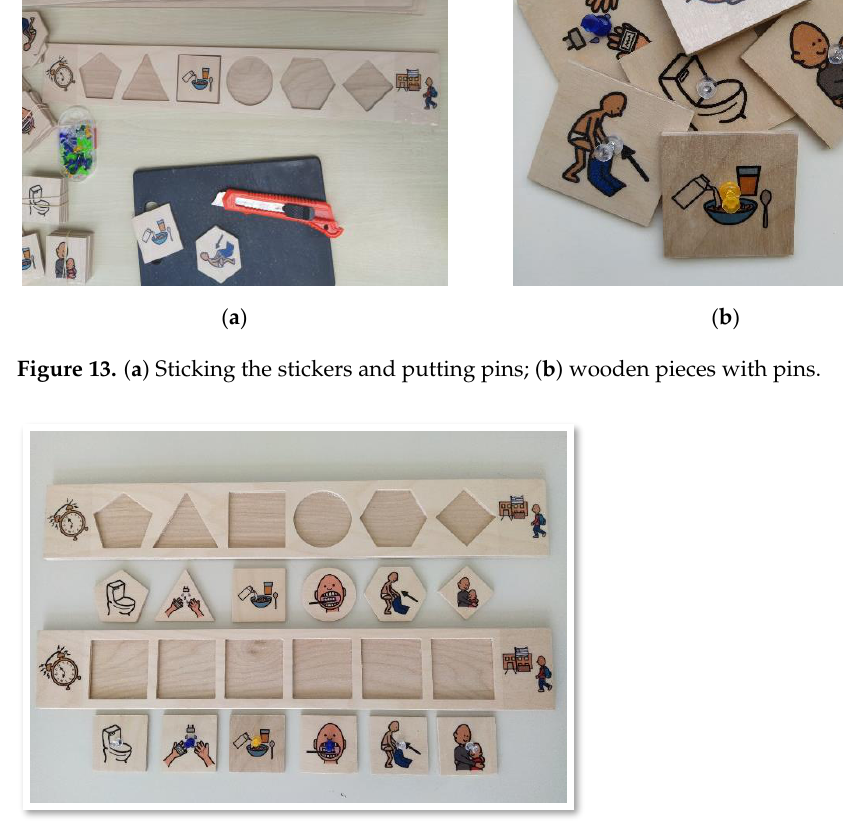
Figure 14. WUIM_Puzzle: the wooden block set consist of wooden boards and pieces.